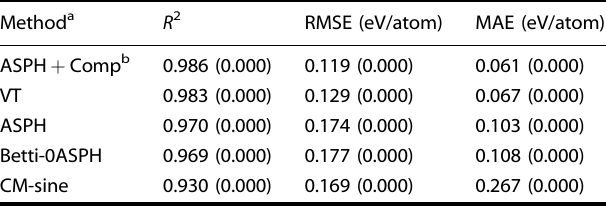
Table 1. The overall performance of formation enthalpy predictor with different feature extraction method on cross-validation (CV)